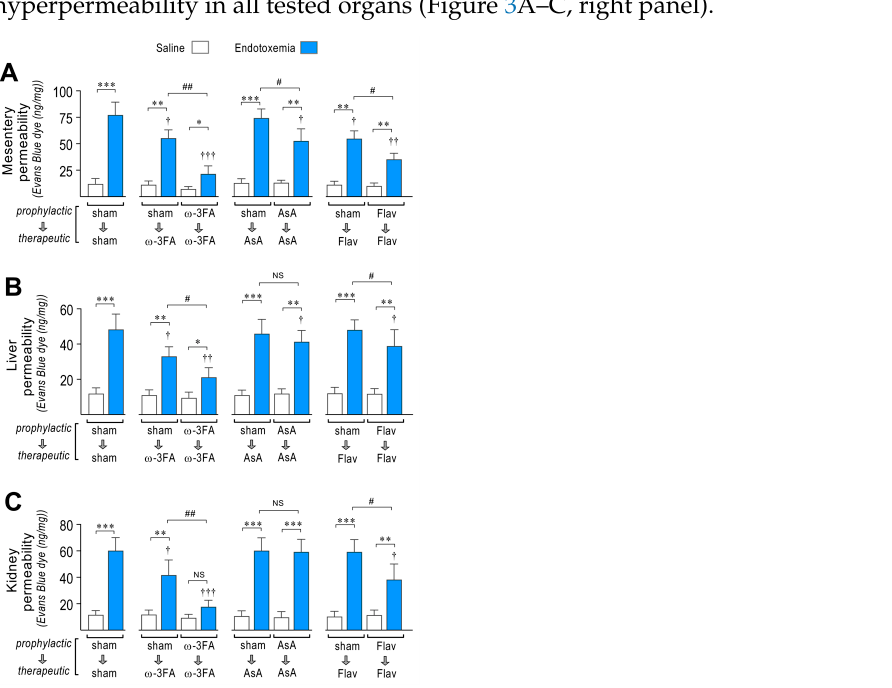
Figure 3. Effects in vascular hyperpermeability through dietary supplementation based on ω -3 FA, ascorbic acid, or polyphenolic antioxidant flavonoids in endotoxemic rats. After saline (open bars) and endotoxemia (blue bars) treatments that were supplemented with water (sham), ω -3 fatty acid ( ω -3 FA), ascorbic acid (AsA), or polyphenolic antioxidant flavonoids (Flav), through a therapeutic and a prophylactic protocol, the mesentery ( A ), kidney ( B ), and liver ( C ) were harvested and processed for EBD extraction to determine blood vessel hyperpermeability. EBD content was normalized to total sample weight. Statistical differences were assessed by two-way ANOVA followed by Dunnett’s post hoc test. * p < 0.05; ** p < 0.01; *** p < 0.001 comparing saline and endotoxemia condition. † p < 0.05, †† p < 0.01, ††† p < 0.001 compared with sham-treated condition. # p < 0.05; ## p < 0.01 comparing non-survivor endotoxic condition between therapeutic and prophylactic protocol. NS: non-significant. Results are expressed as the mean ± SD ( N =